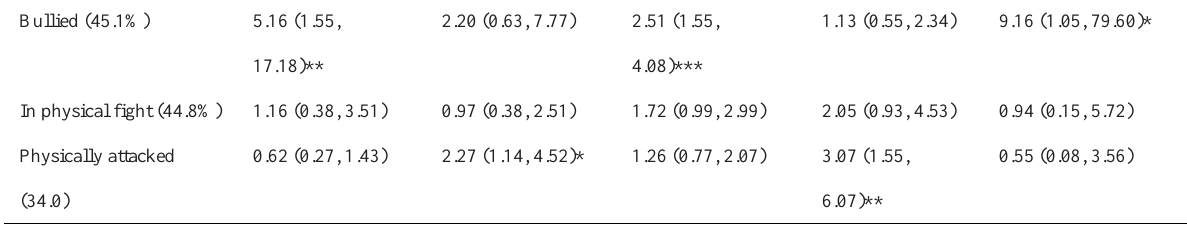
Table 4. Factors associated with lifetime amphetamine